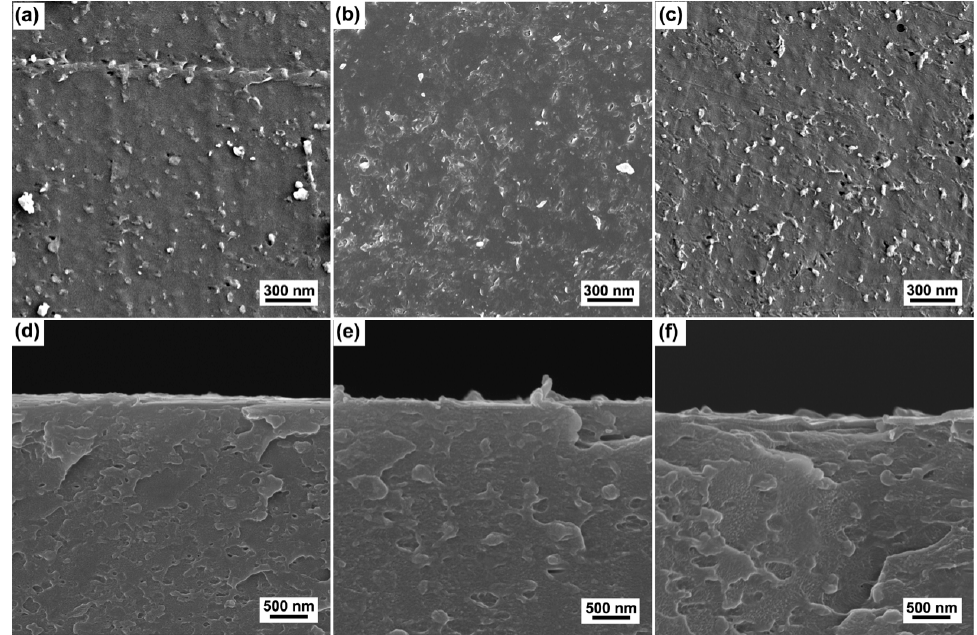
Figure 1. Typical surface ( a – c ) and corresponding cross-sectional ( d – f ) SEM images of the raw ABS ( a , d ) and the ABS substrates treated by Cr ions for 30 s ( b , e ) and 3 min ( c , f ) with bias voltage of − 400